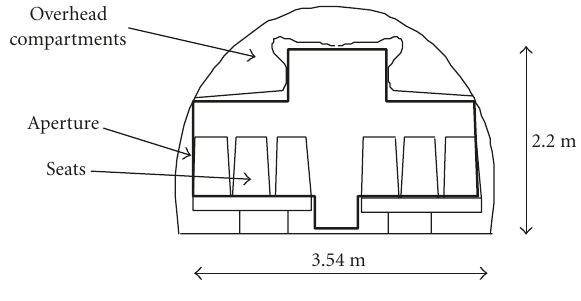
Figure 11: Cross-section of the cabin.